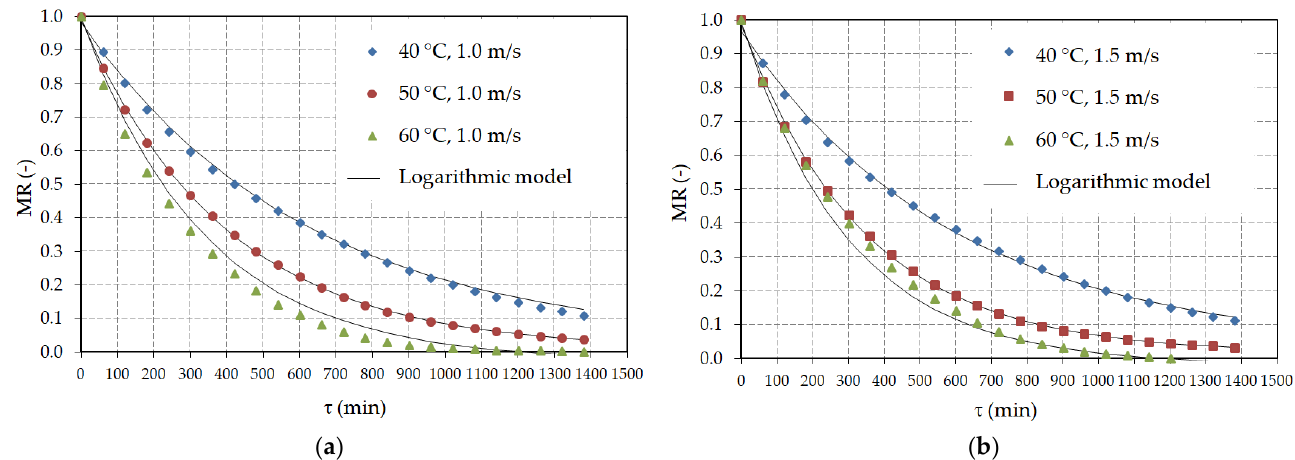
Figure 3. Drying curves of the hot air drying process of the control group (fresh apricot halves): ( a ) air velocity 1.0 m/s, ( b ) air velocity 1.5 m/s.